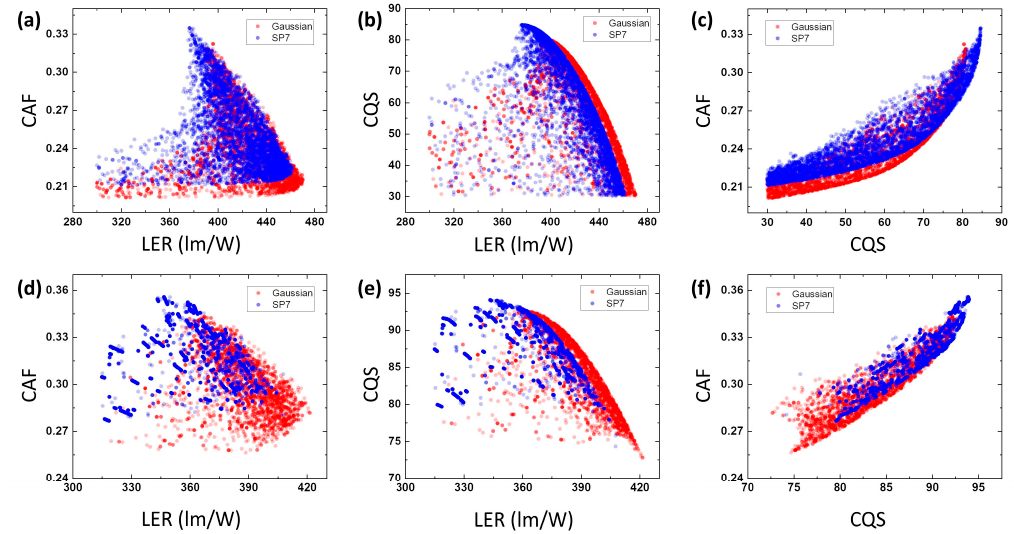
Figure 3. Pareto Fronts in three-view diagrams of optimized ( a – c ) RG P B- and ( d – f ) RY P G P B-type solid-state lighting (SSL) at a fixed correlated color temperature (CCT) (2700K). Both Gaussian and SP7 model are calculated for comparison.